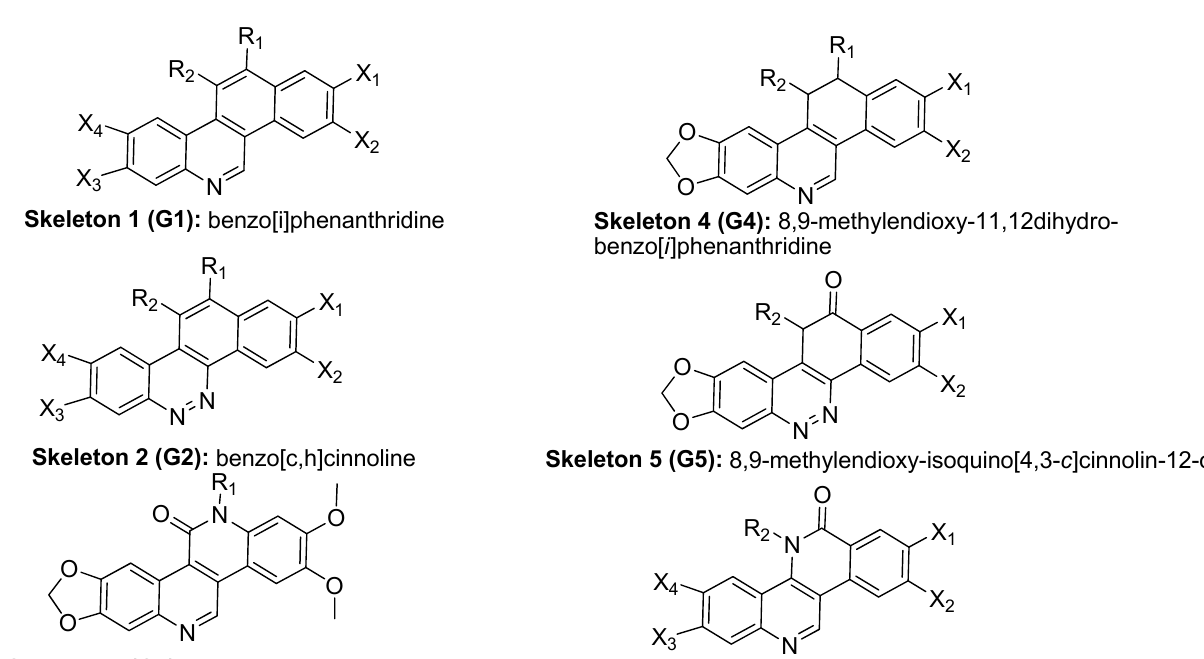
Figure 2. General structural skeletons of the BCPs dataset.